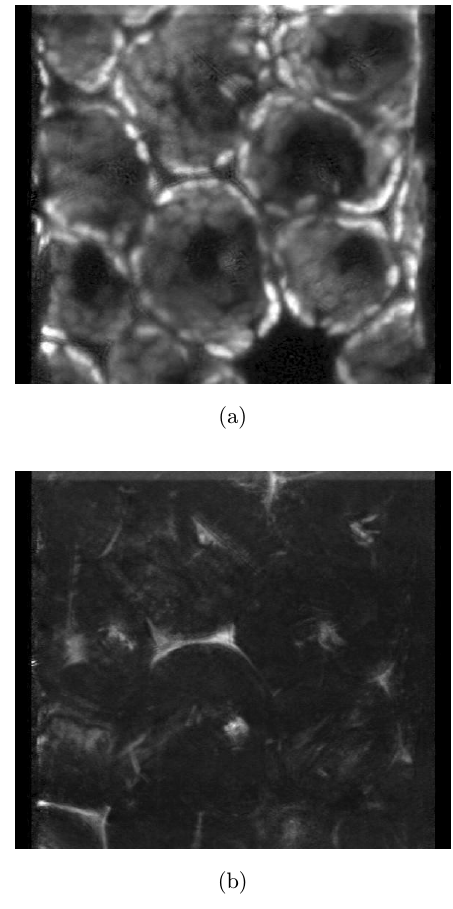
Fig. 12. FMM °uorescence (a) and scattering (b)